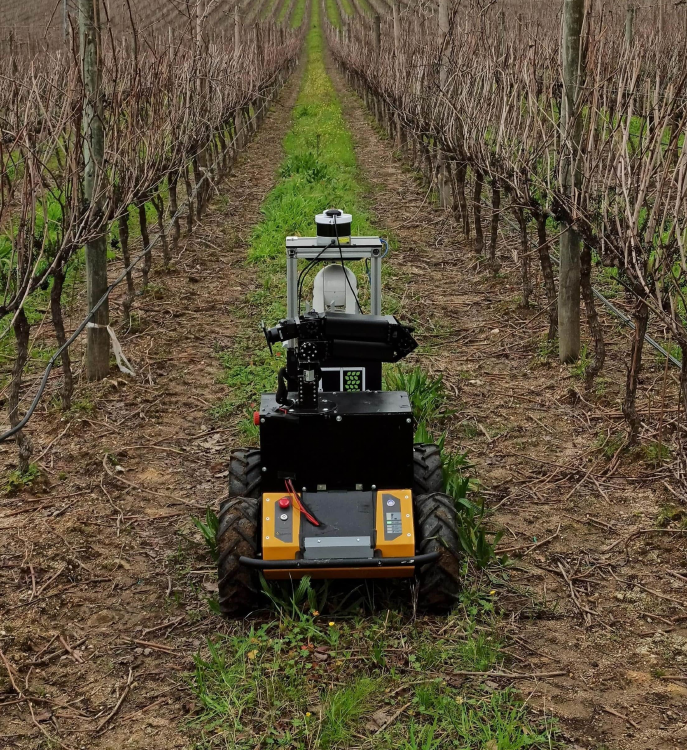
Figure 1. Agricultural robot used to collect visual data with onboard cameras pointing to the